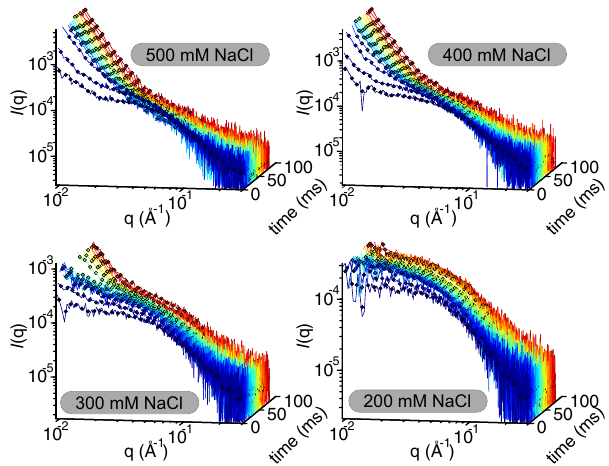
Fig. 6 The time evolution of the form factor in laminar- fl ow TR-SAXS experiments. Raw data is displayed for all samples as lines and logarithmically smoothed data as fi lled circles. Curves from early time points are shown blue, from late time points red, with a color gradient to indicate time evolution for in-between time points. The fi rst recorded curve is shown to represent each time